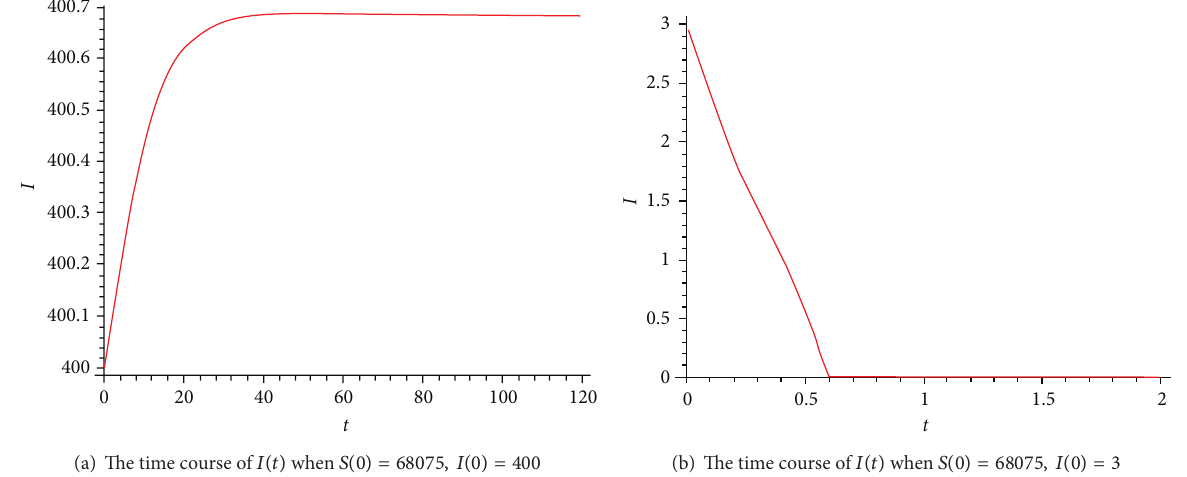
Figure 5: Different initial states bring different results. The parameters are 𝐴 = 15000, 𝛽 = 0.0005, 𝑑 = 0.02, 𝑏 = 0.01, ] = 34, 𝑐 = 7.16 , and = 0.50 . The unit of time 𝑡 is R 0